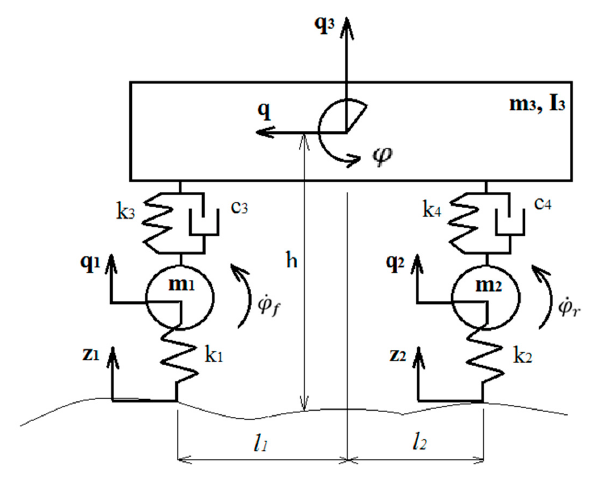
Table 1. Parameters for mathematical model (MM).